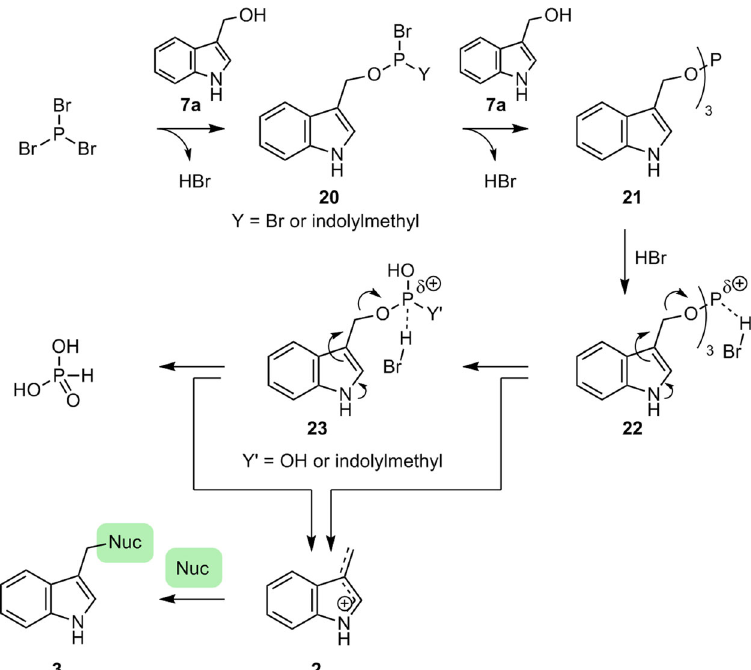
Fig. 5 Plausible mechanism. Plausible mechanism for rapid and mild generation and nucleophilic substitution of extremely active (1 H -indol-3-yl)methyl electrophile 2